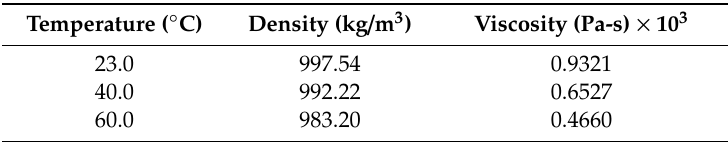
Table 2. Physical properties of water.